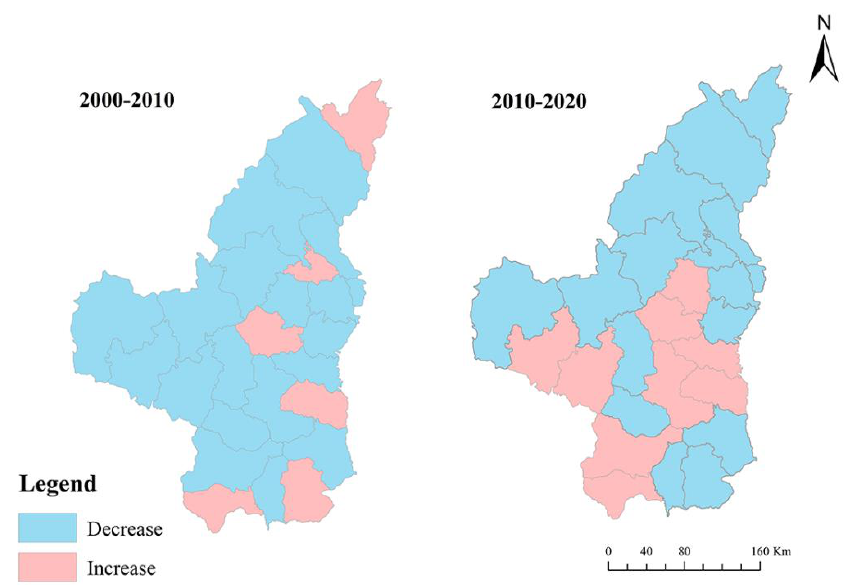
Figure 5. Changes in the ESV by districts and counties in the Loess Plateau of Northern Shaanxi.